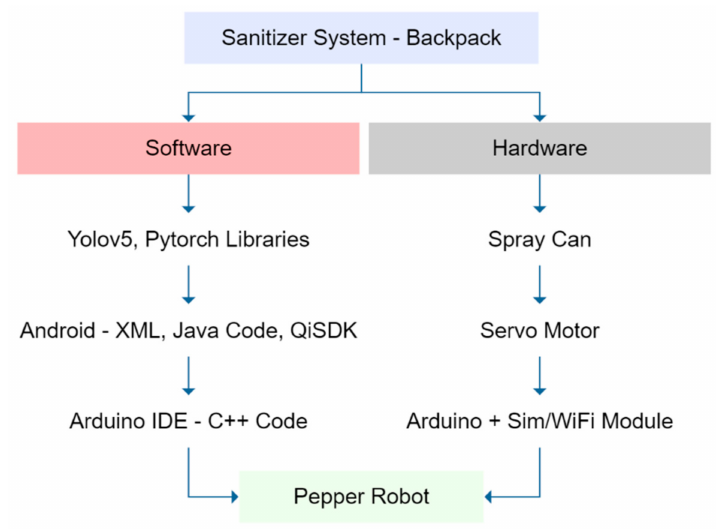
Figure 6. Autonomous hand sanitizer setup.